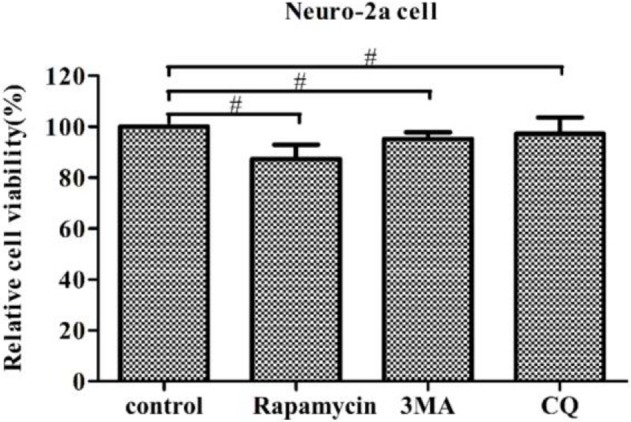
Regulation of autophagy does not affect cell viability. The pharmacological alteration of autophagy does not affect cell viability. Neuro-2a cells were determined by WST-8 cell proliferation assay after being treated with rapamycin, 3-MA, or chloroquine (CQ) for 24 h. Data on the percentage of cell viability are shown as the mean ± SD for three independent experiments. #P > 0.05.